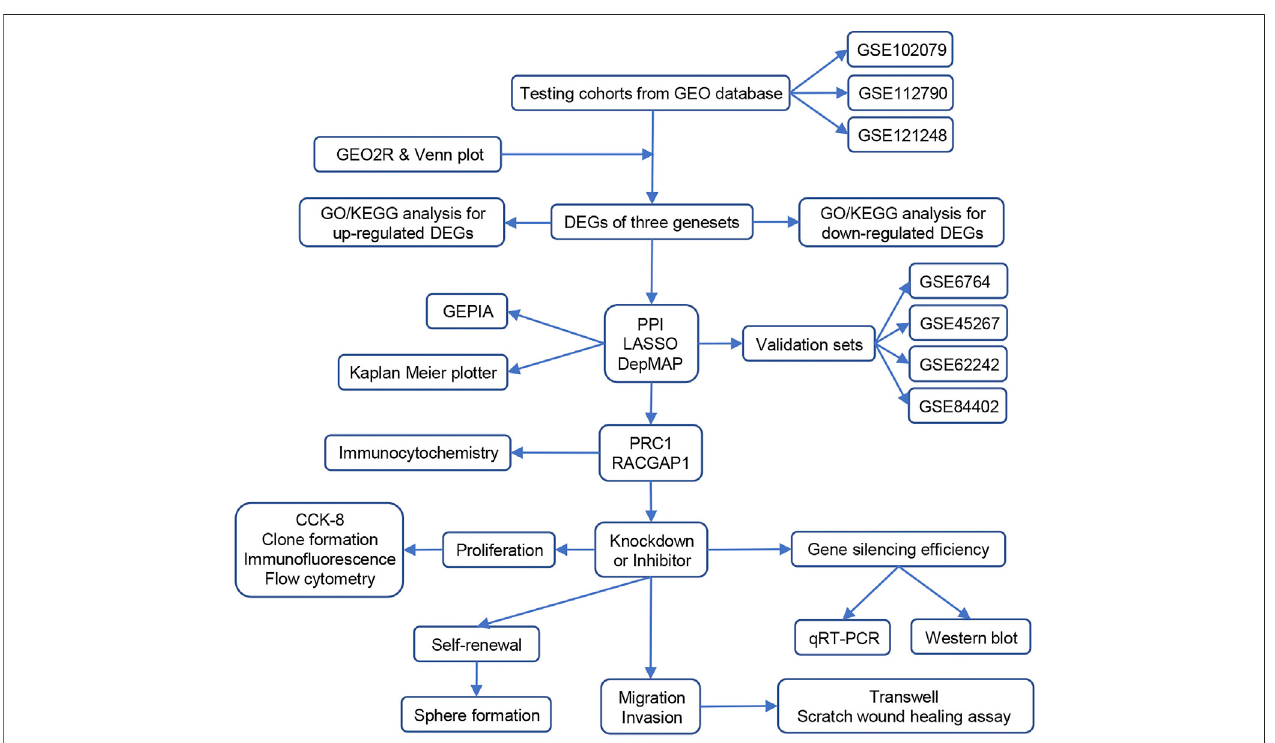
FIGURE 6 | Schematic illustration of data processing and experimental veri fi cation of this study.